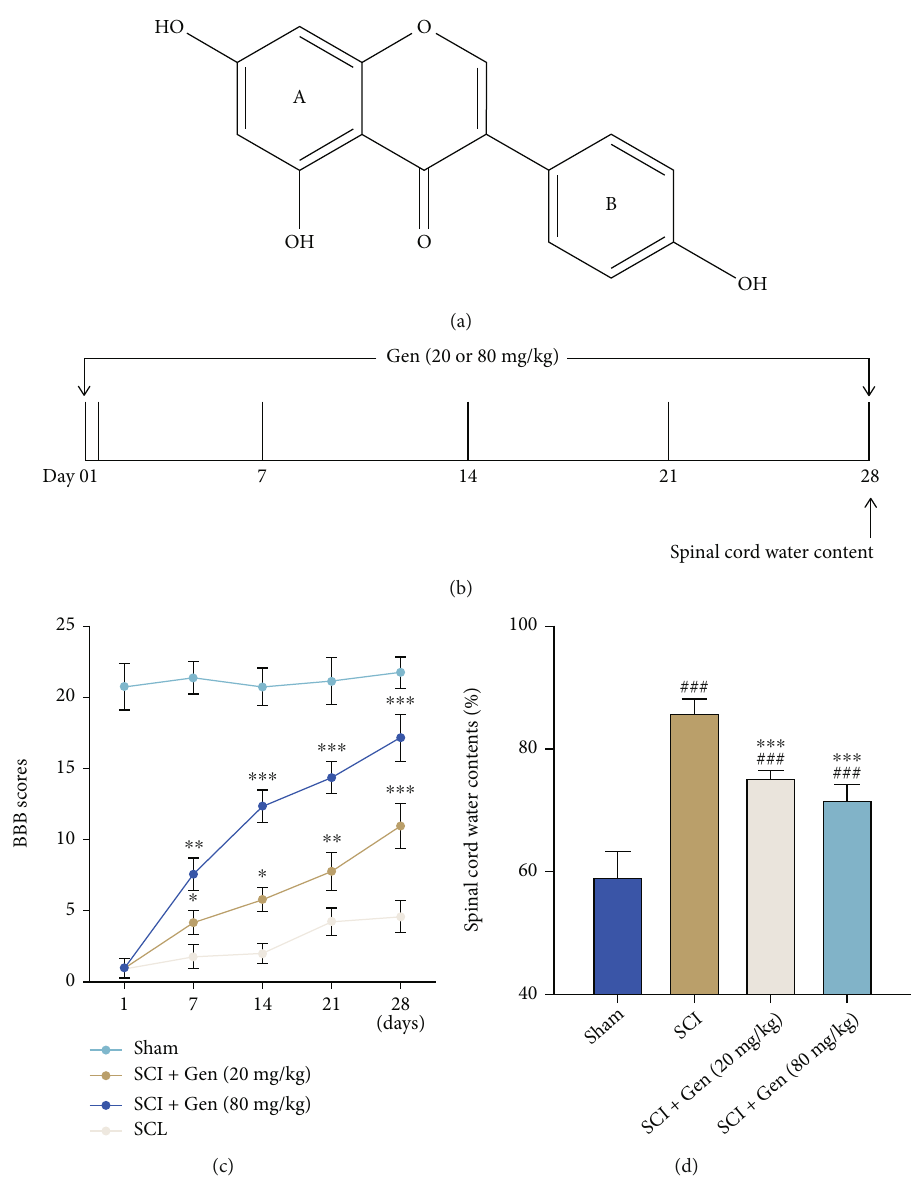
Figure 1: Genistein improved recovery in SCI mice. (a) The chemical structure of genistein. (b) The protocol of genistein for treatment of SCI mice. (c) At the indicated day, the changes of BBB scores in di ff erent mice with or without genistein treatment. (d) On 28 th day, measure and compare the water content of spinal cord in di ff erent mice. Five mice in each group, and data were expressed as mean ± SD . P value was calculated by post hoc comparisons. ∗ P < 0 : 05 , ∗∗ P < 0 : 01 , and ∗∗∗ P < 0 : 001 vs. SCI group. ### P < 0 : 001 vs. sham